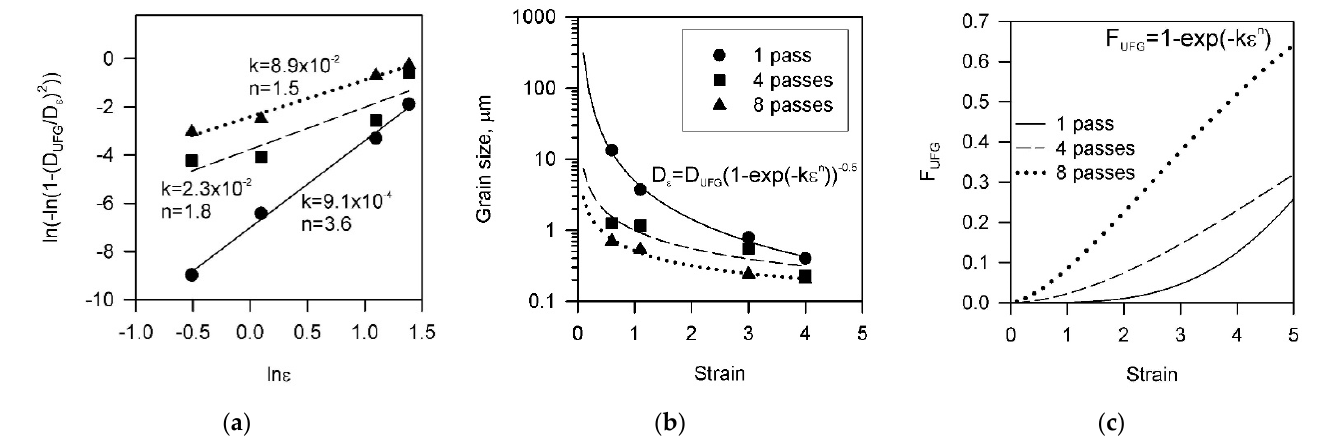
Figure 7. Relationships between the rolling strain and ln(–ln(1 − D UFG2 D ε − 2 )) ( a ), the grain size ( b ), and the fraction of ultrafine grains ( c ) in a Cu-Cr-Zr alloy subjected to 1 to 8 passes of ECAE-Conform followed by cold rolling up to total strain of